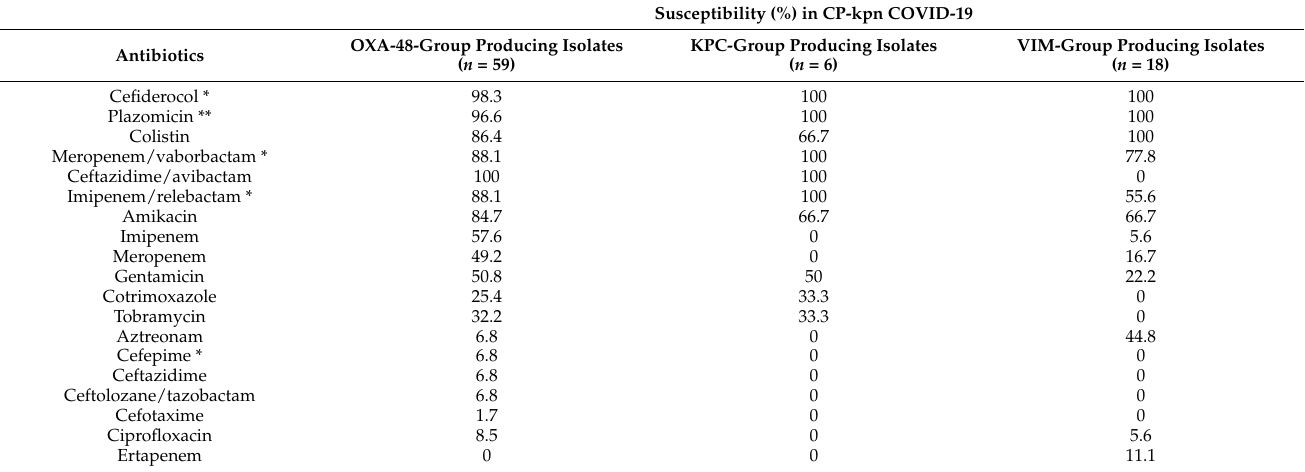
Table 2. Antibiotic susceptibility according to carbapenemase groups in CP-kpn COVID-19 isolates.